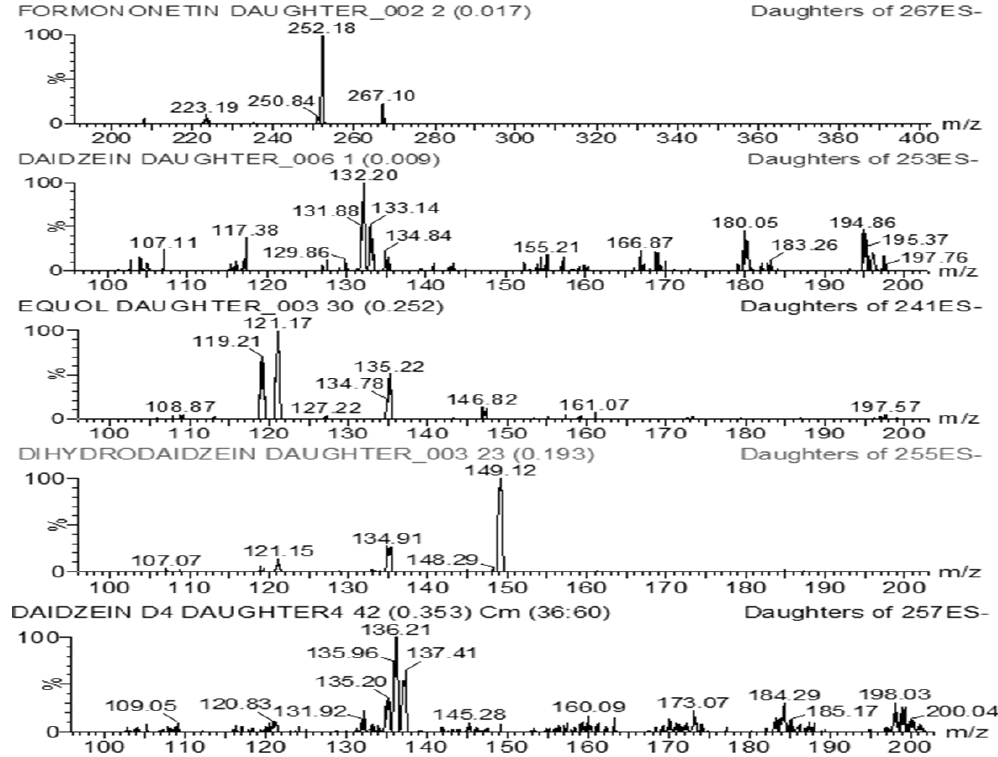
Figure 2. The representative chromatograms of blank sample, blank sample spiked with target analytes and IS (LLOQ or ULOQ concentration) are presented in Figure 3.